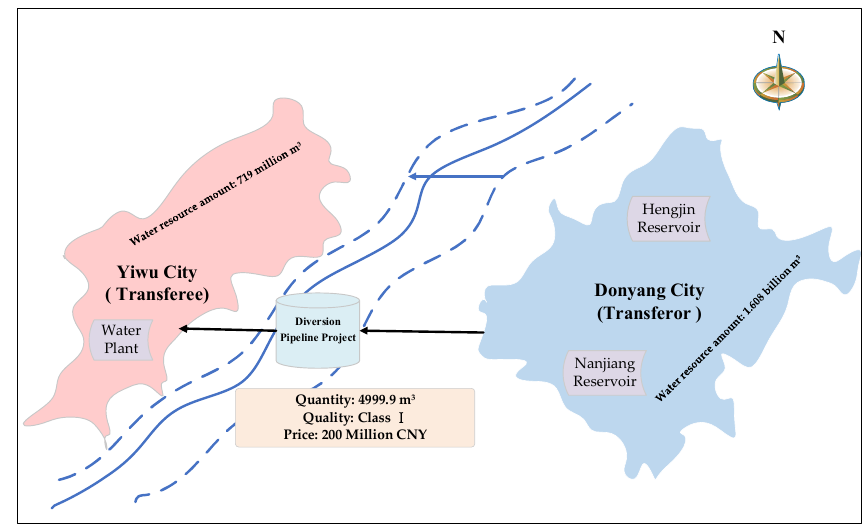
Figure 4. Schematic diagram of the Dongyang-Yiwu water rights transaction.